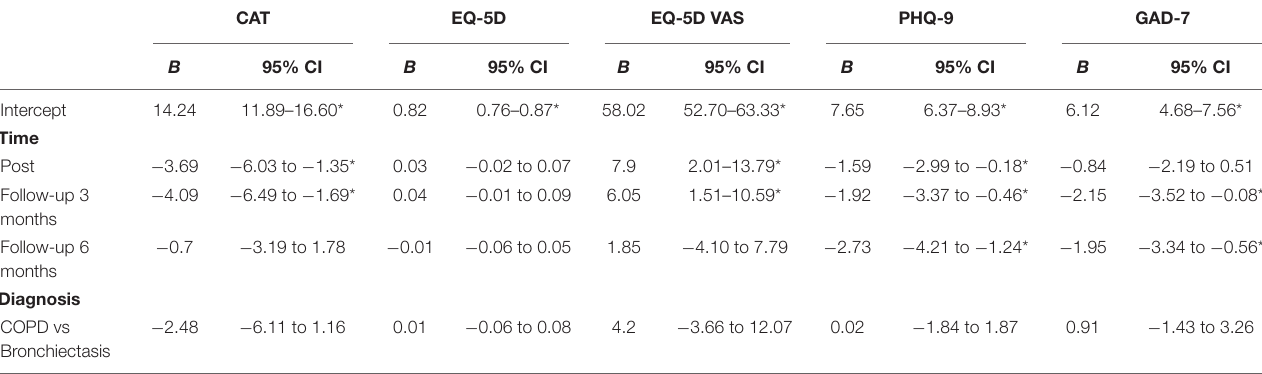
TABLE 2 | Results of the mixed linear models testing the differences in the main outcomes over time. CAT EQ-5D EQ-5D VAS PHQ-9 GAD-7